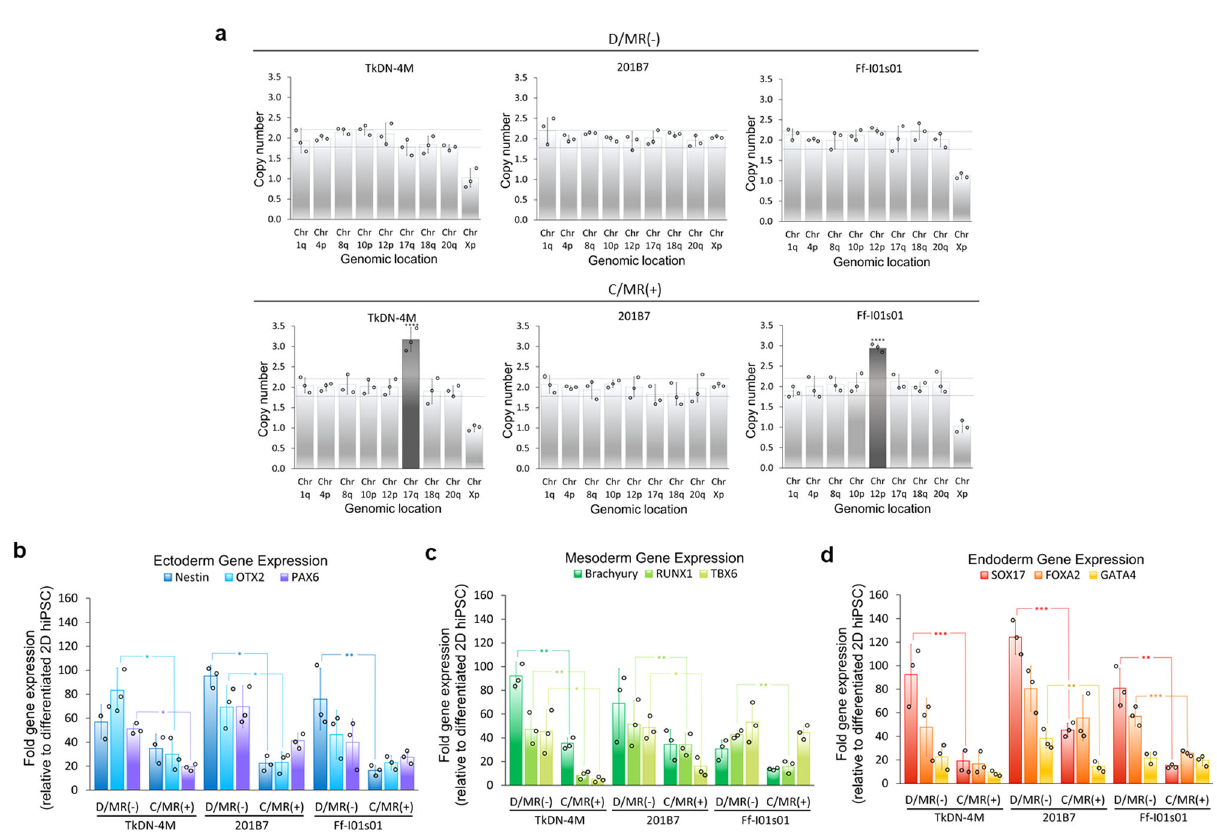
Fig. 6 Genomic stability and differentiation potential of hiPSCs after long-term culture. a Chromosomal abnormality was detected in two hiPSCs cultured in C/MR( + ) ( n = 3 biologically independent experiments). A copy number <1.8 or >2.2 (showing by dotted line) with p value ≤ 0.05 in Chr 1q-20q indicates the presence of chromosomal abnormality in the culture (indicated by the black bar). The Chr Xp showed the sex chromosome with normal copy number 2 or 1. The direct differentiation assay was performed to validate the ability to differentiate into three germ lineage. The gene-expression levels of the trilineage marker of the germ layers were evaluated by qPCR: b ectoderm ( Nestin, OTX2 , and PAX6 ), c mesoderm ( Brachyury, RUNX1 , and TBX6) , and d endoderm ( SOX17, FOXA2 , and GATA4 ). All gene expression was normalized by the differentiated monolayer hiPSCs from day − 1. The C/MR( − ) culture group without medium replacement was excluded from the analysis due to the insuf fi cient yield after the fi rst passage ( n = 3 biologically independent experiments). Mean± standard deviation are indicated in each graph. Statistical signi fi cance: **** p < 0.0001; *** p < 0.001; ** p < 0.01; * p < Monolayer hiPSC culture . The TkDN-4M hiPSC line was provided by the Stem Permeability test in cell-free conditions . The effect of FP003 on device perfor- Cell Bank, Centre for Stem Cell Biology and Regenerative Medicine, University of mance was measured by glucose and lactic acid measurements during a 12h Tokyo (Tokyo, Japan) 56 . The 201B7 was provided by the Center of iPS Research penetration test under cell-free conditions. Low-glucose DMEM (2 mL; Sigma- Aldrich, St. Louis, MO, USA) containing 0.2% FP003 and 0.8g/L lactic acids and Applications (CiRA), Kyoto University (Kyoto, Japan), and Ff-I01s01 was (Sigma-Aldrich) was added to the upper culture compartment, and 15mL of high- glucose DMEM (Sigma-Aldrich) was placed in the lower dialysate compartment. The dialysis-culture system was then placed in a 120-rpm rotary shaker. We col- lected 50-µm samples of the medium every 2h and measured changes in glucose and lactic acid concentration using a YSI 2950 multipurpose bioanalyzer (YSI, Yellow Springs, OH, USA). To test the ability of the device to accumulate macromolecules in the upper culture compartment and differences in permeation of differently sized molecules, 2µg/mL FITC (Sigma-Aldrich) at different molecular weights (4, 10, and 20 kDa) LDH release assay . HiPSC aggregates were formed by inoculation of a 2× 10 6 was added to the upper culture compartment. This experiment was performed single-cell suspension/well in six-well plates for 24 h culture in complete medium using DMEM basal medium in both compartments, similar to the penetration test supplemented with 0.2% free-fatty acid-bovine serum albumin (BSA) in a 90-rpm for macromolecules. Medium samples were collected after 12h, and FITC rotary shaker. The formed aggregate was transferred to dialysis culture system (D/ concentration was measured using a Wallac Arvo SX 1420 multilabel counter MR( − )) with or without 0.2% FP003 and cultured with a rotary shaker at 120 rpm. (PerkinElmer, Waltham, MA, USA). The cells were harvested by sedimentation in 10-mL tubes, and the supernatant was